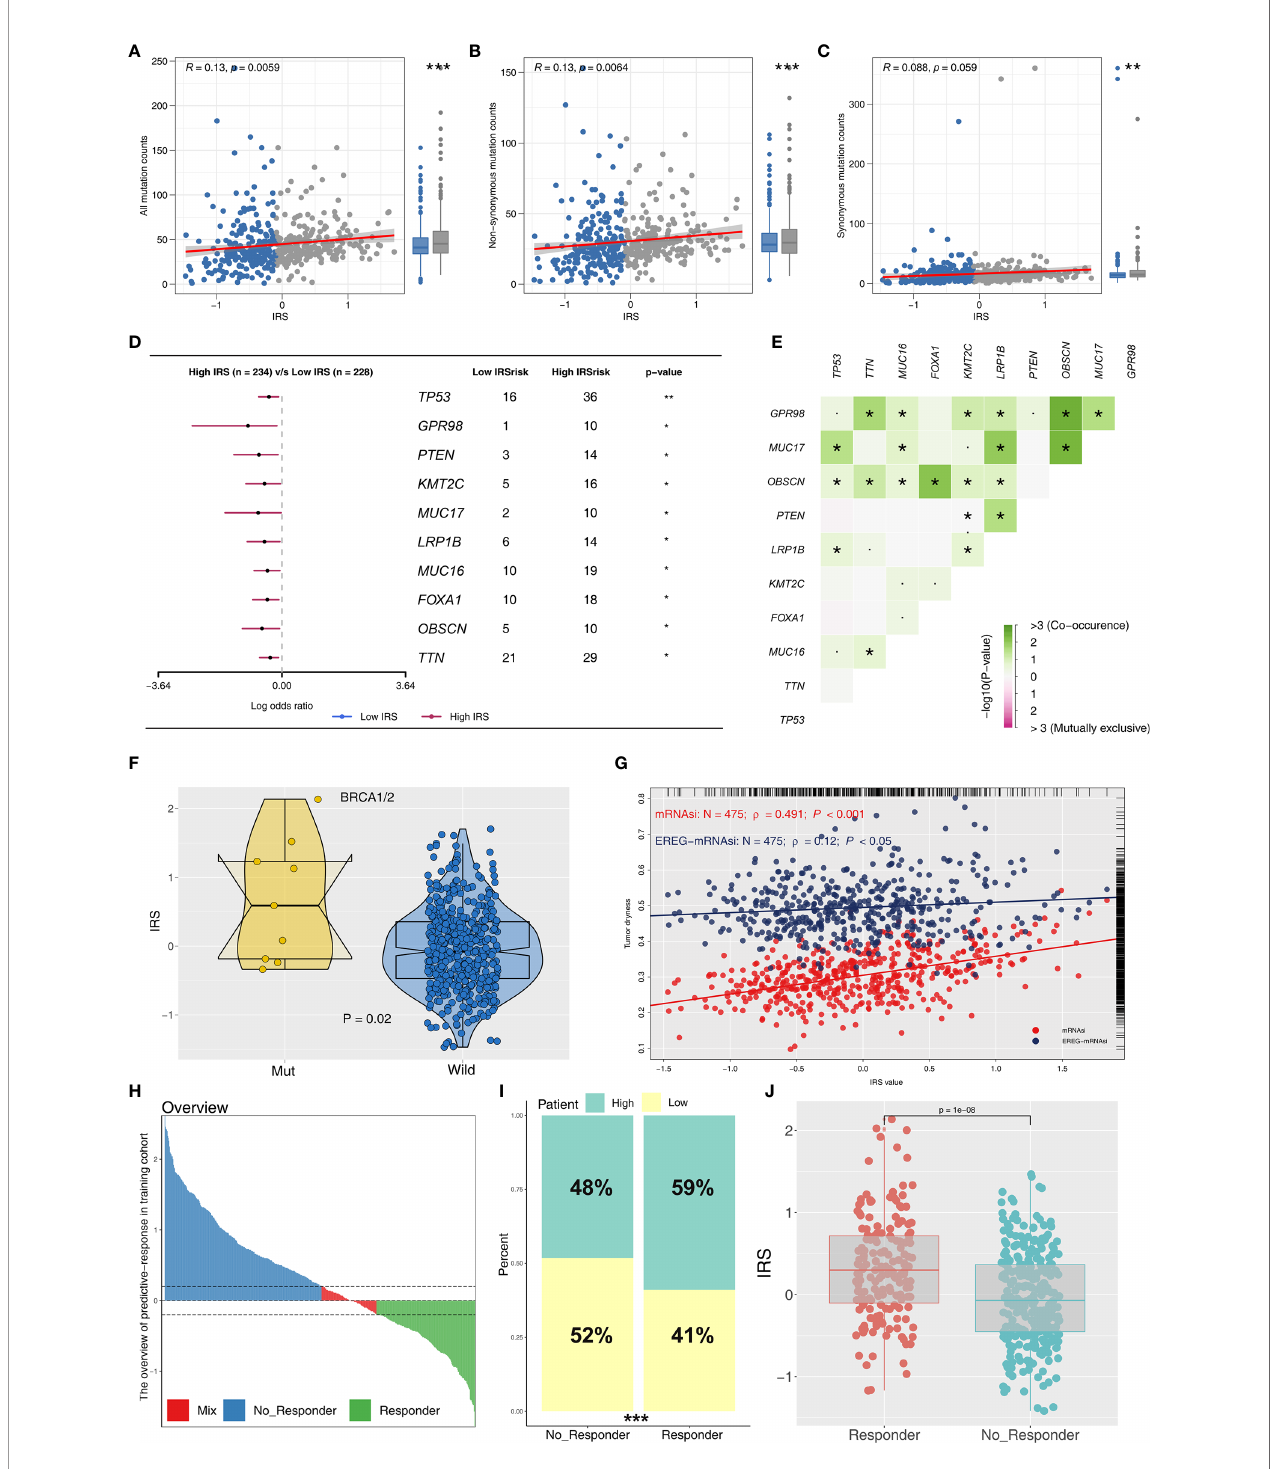
FIGURE 7 | Correlation of IRS with mutation, tumor stemness, and immunotherapy response rate. (A – C) The association between genome mutation counts and IRS. (D) Gene mutation difference between high and low IRS patients. (E) Comutation relationship of mutation genes. (F) IRS value in BRCA wild and mutation samples. (G) IRS was positively associated with tumor stemness (mRNAsi and EREG-mRNAsi). (H) The overview of predictive immunotherapy response rate in the combined PCa cohort using the TIDE analysis. The patients with TIDE value < − 0.2 were regarded as responders and those >0.2 were regarded as